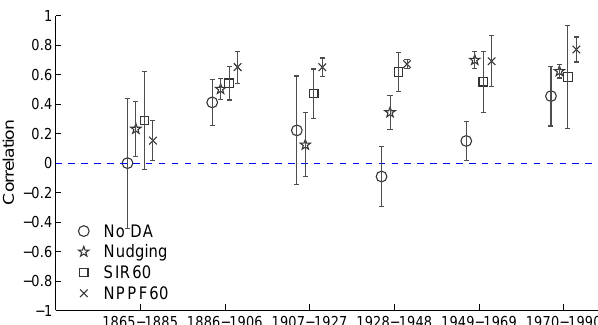
Fig. 9. Same as Figure 8, but for sea ice concentration.